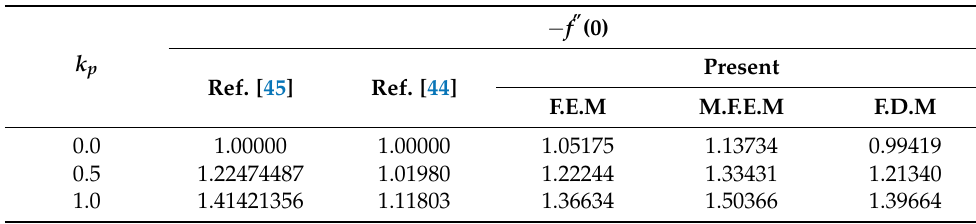
Table 2. Comparison of presents approaches with past research for computing numerical values of − f (cid:48)(cid:48) ( 0 ) using λ = 0 = M